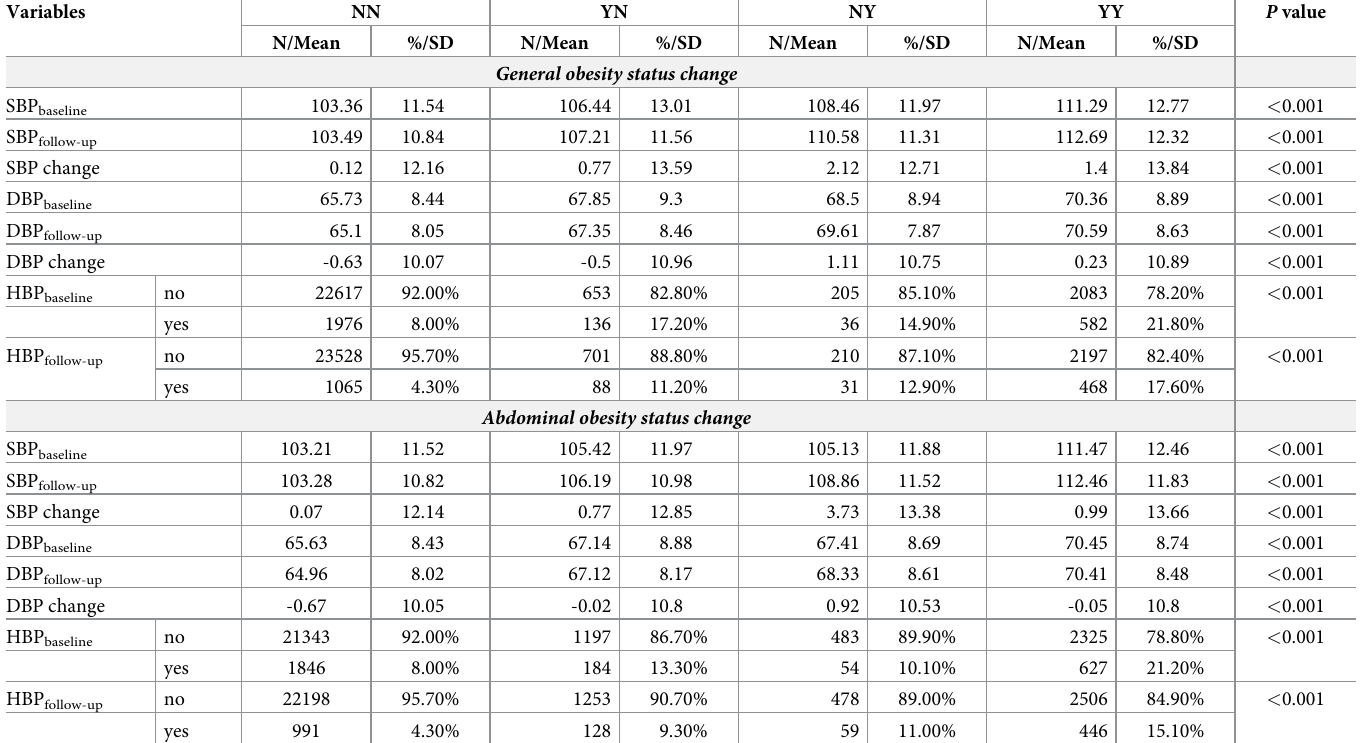
Table 2. Blood pressure level and risk of high blood pressure of different pattern of general or abdominal obesity.